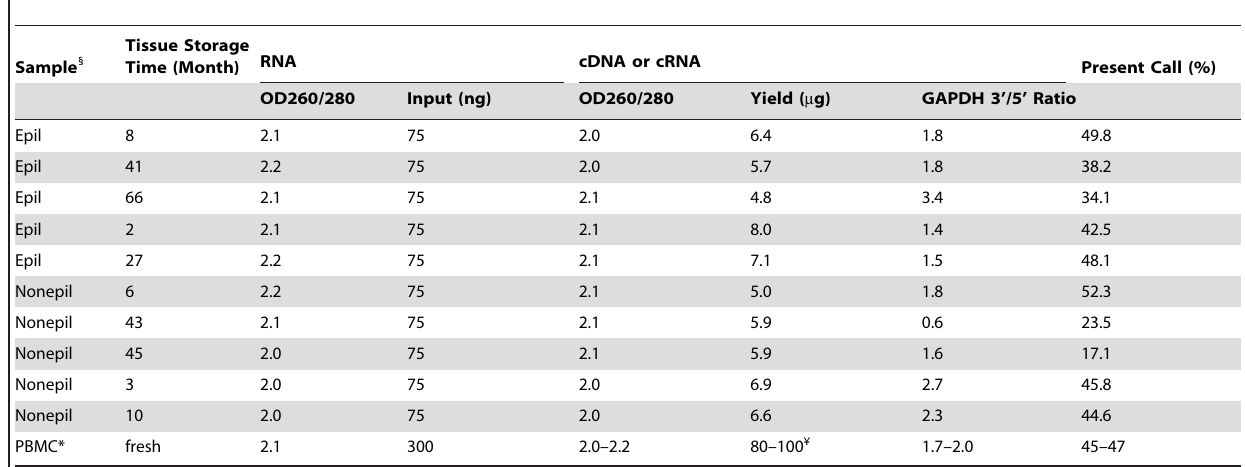
Tissue Storage Time (Month) Sample 1